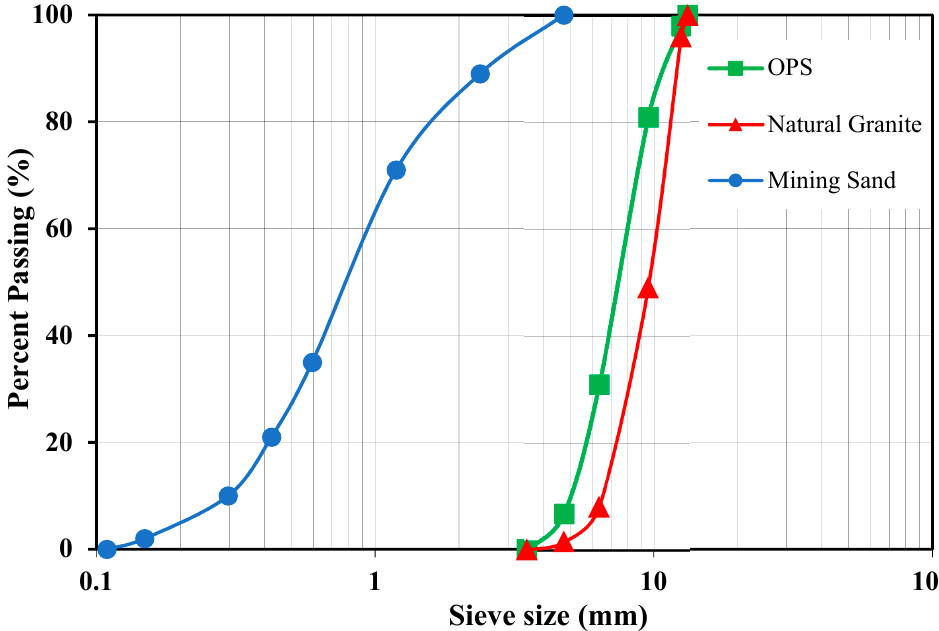
Figure 2. Gradation of mining sand, OPS, and natural granite.